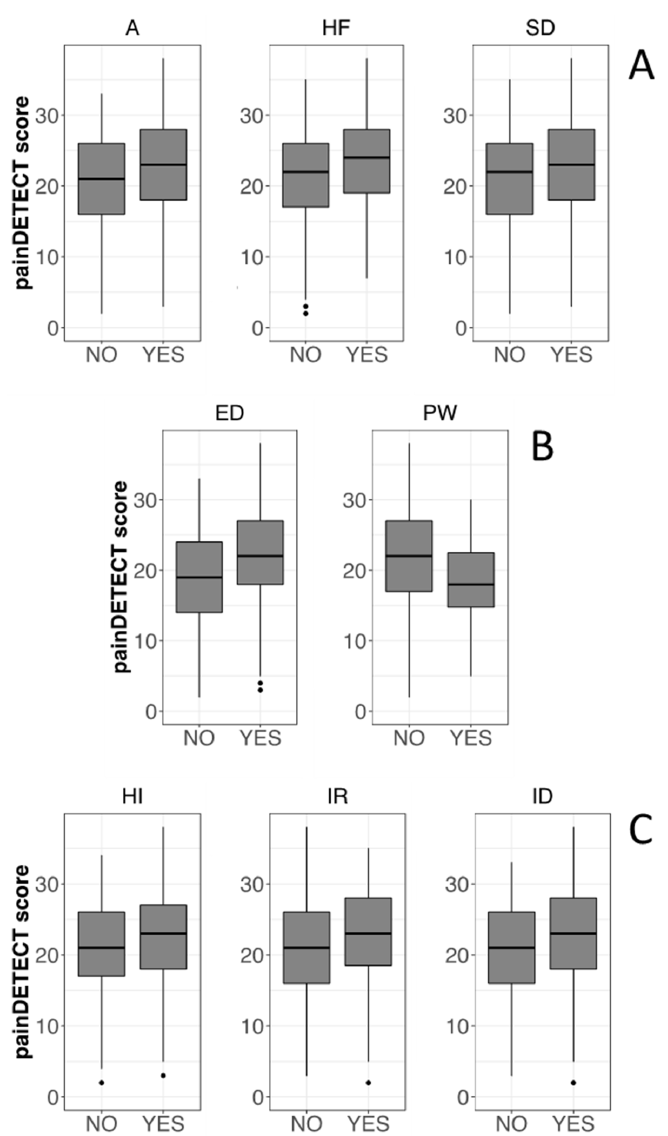
Figure 6. Boxplots showing the correlation between PD ‐ Q scores and CBA ‐ H categories. For each category of the CBA-H test, two groups have been identified based on the cutoff for the presence of the related clinical concern, indicated by the YES label, except for PW (Psychophysical wellbeing) where YES indicates a positive condition. Boxplots have been then obtained showing the frequency distributions of the PD ‐ Q scores for each of the two groups. Only the categories with significant differences between the NO and YES cases are shown (Mann–Whitney test, p < 0.05). CBA ‐ H test;